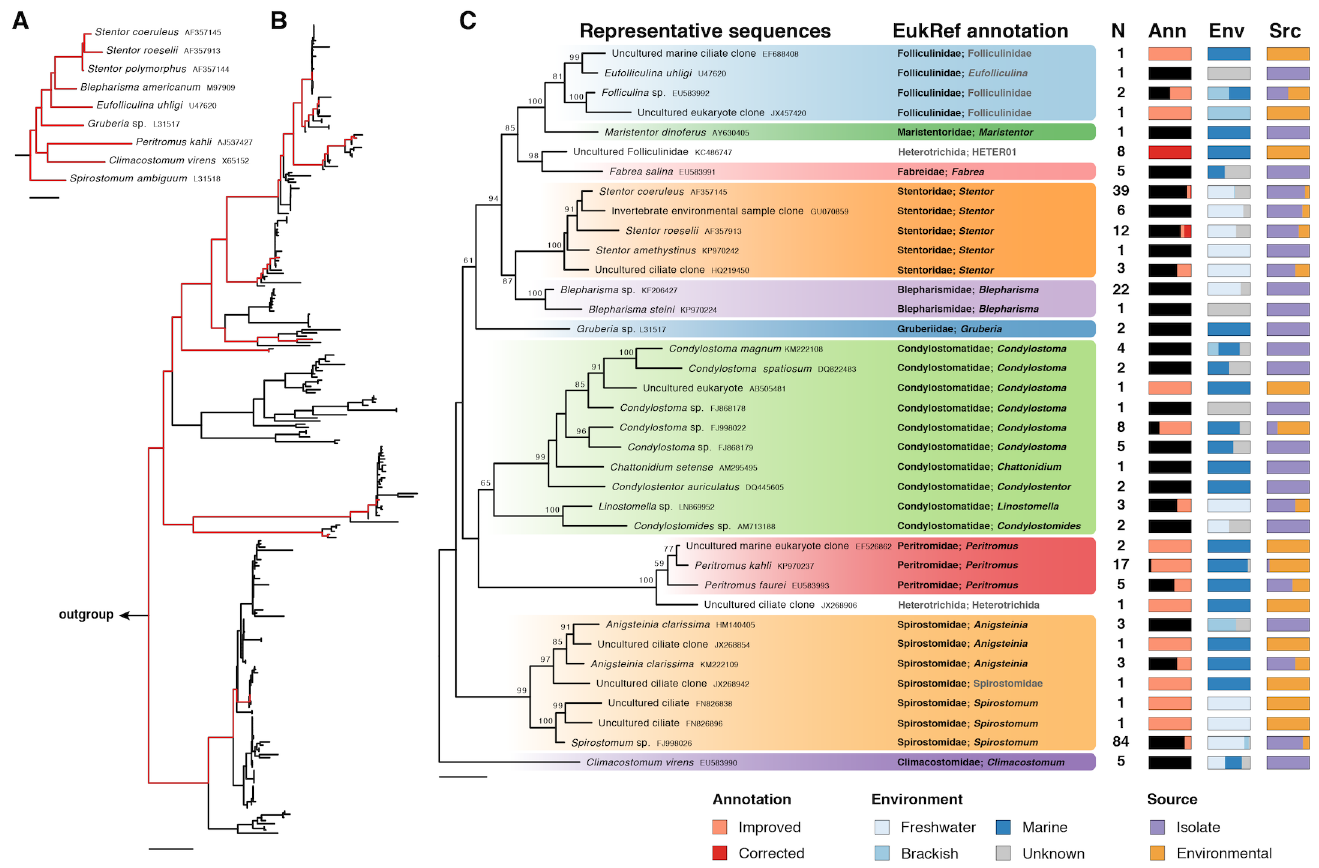
Fig 3. Case study of Heterotrichea, Ciliophora. (A) Phylogenetic tree of sequences used as input into the EukRef pipeline. (B) Phylogenetic tree following EukRef pipeline. Branches and leaves in red correspond to those present in the input dataset (in A); branches and leaves in black are those acquired by the EukRef pipeline and exclude artifacts and sequences discarded during curation that fell outside the group of interest. Output tree was used as a guide to perform the taxonomic annotation. (C) Output of EukRef curation. Representative sequences: output phylogenetic tree depicting representative sequences clustered at a 97% similarity threshold. EukRef annotation: taxonomic annotation following curation, which is propagated to all sequences in the 97% cluster ( N , number of sequences in each cluster). Column Ann: proportion of sequences for which annotation was unchanged (black), improved (pink), or corrected (red). Metadata are added to the curated database for each sequence based on GenBank record and/or information in publications associated with the sequences. Column Env: portion of sequences in the cluster found in marine, freshwater, brackish, or unknown environment. Column Scr: portion of sequences derived from environmental sequencing or known isolates (either cultures or morphologically identified cells). Fully curated reference database of Heterotrichea available in S3 Data. Ann, annotation; Env, environment; Scr, source.